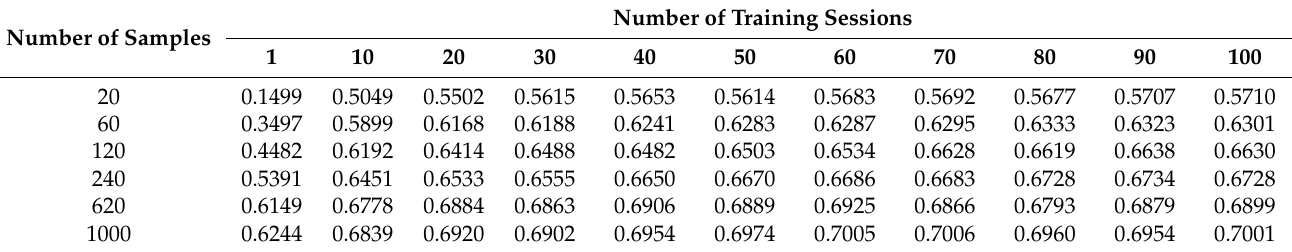
Table 7. Effect of using one fully connected layer.